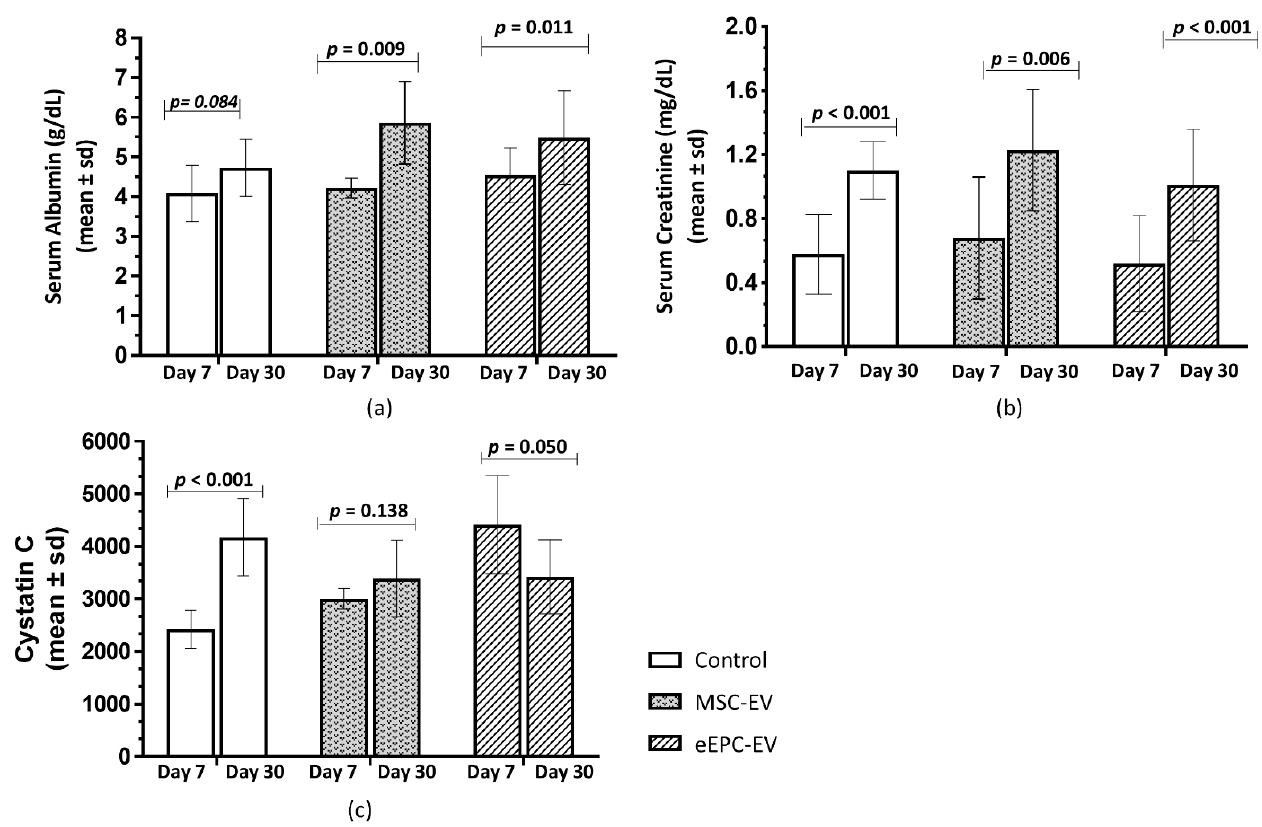
Figure 4. Serum albumin, creatinine and cystatin C evaluation. Analysis was performed on the 7th day after CKD induction by adenine and on the 30th day after infusion with EVs. ( a ) There was a significant difference in serum albumin levels between the MSC-EV and eEPC-EV groups. ( b ) Sig- nificant increase in serum creatinine in all the groups. ( c ) Significant increase in cystatin C levels in the control group. The data in are reported as the mean ± sd. p < 0.05 is considered significant.